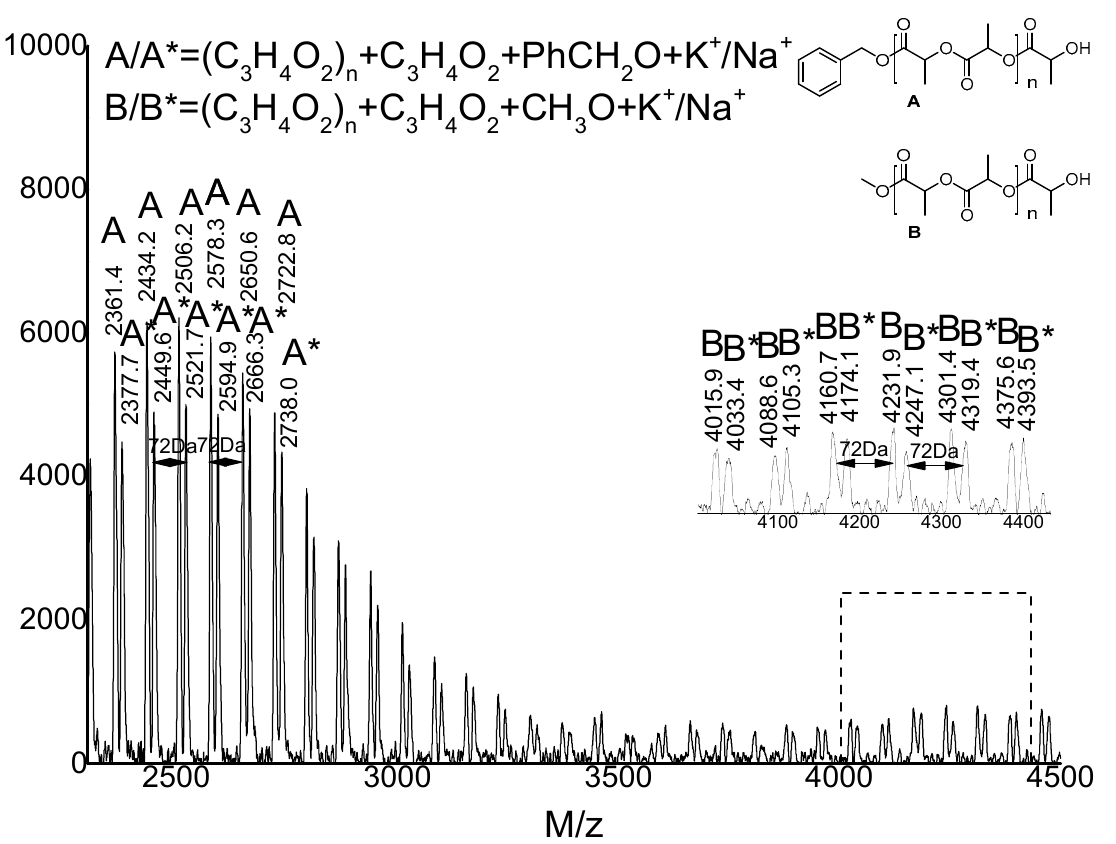
Figure 5. MALDI-TOF spectrum of PLLA obtained by K2 and 10 equiv. BnOH (run 9, Table 2).